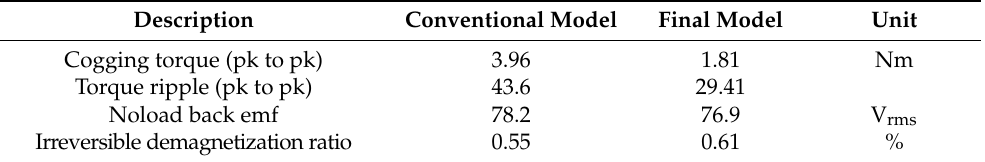
Figure 20. Torque waveforms for the conventional model and the final model. Table 2. Conventional model and final model performance comparison.